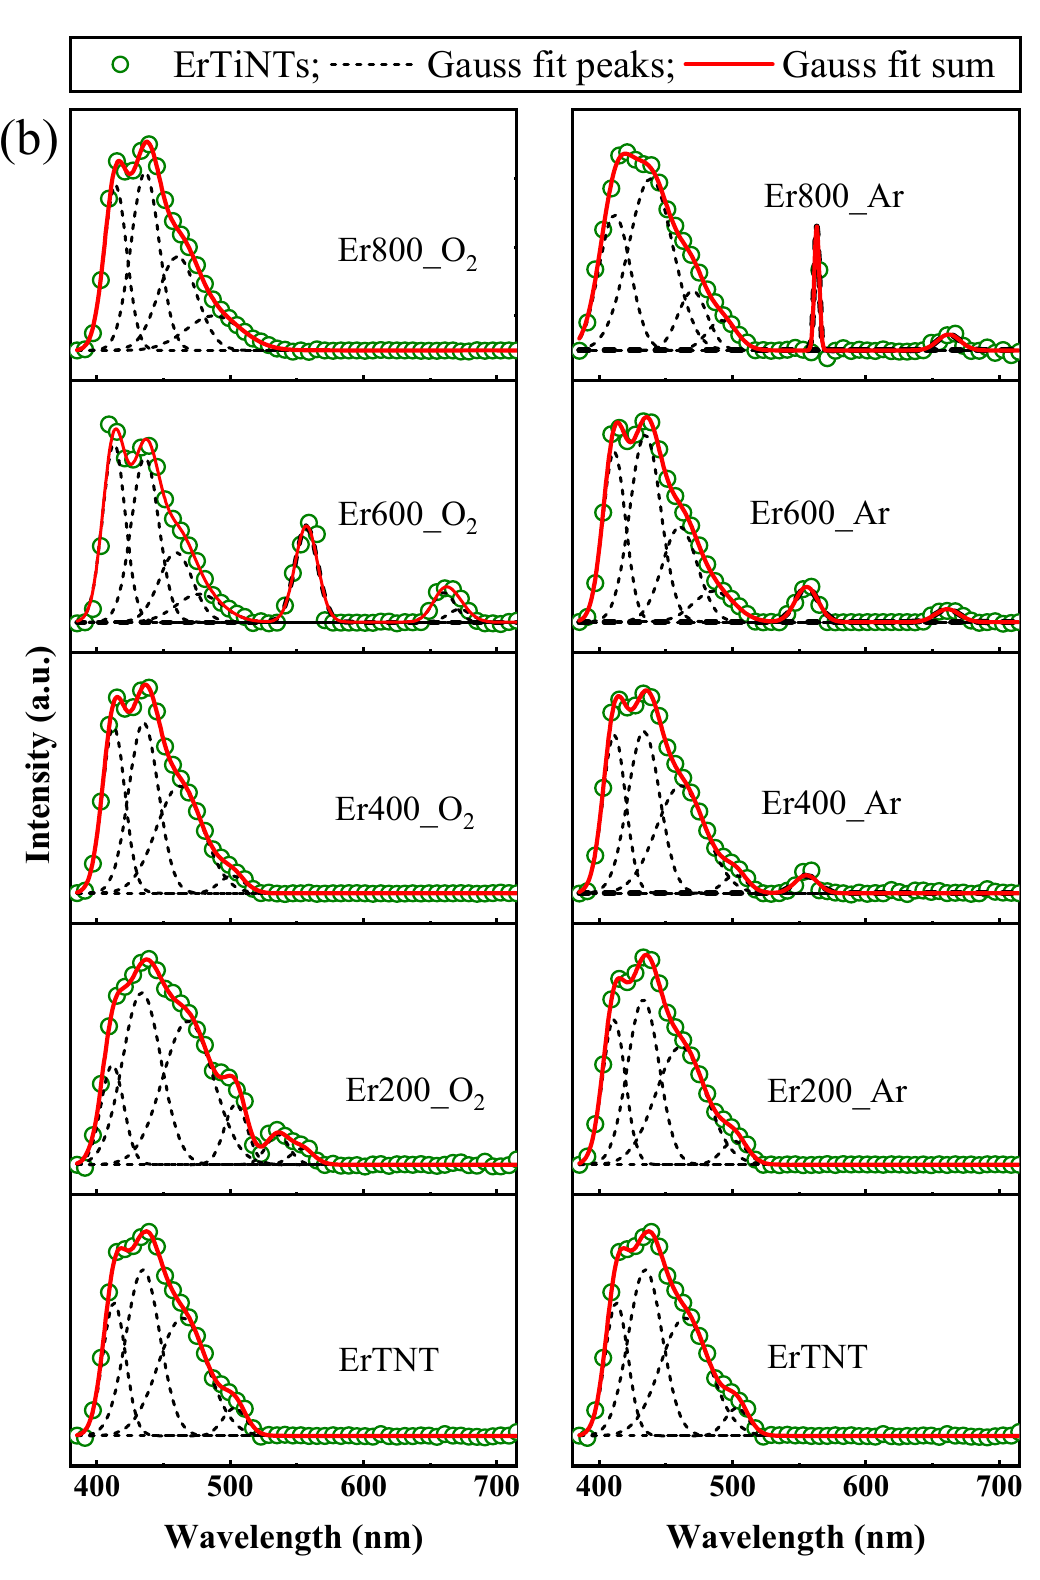
Figure 9. ( a ) Deconvolution of the PL emission spectrum (excitation at 370 nm) of NaTiNTs heat treated in air and argon atmosphere (the upper caption is the same for all samples); ( b ) deconvolution of the PL emission spectrum (excitation at 370 nm) of ErTiNTs heat treated in air and argon atmosphere (the upper caption is the same for all samples).